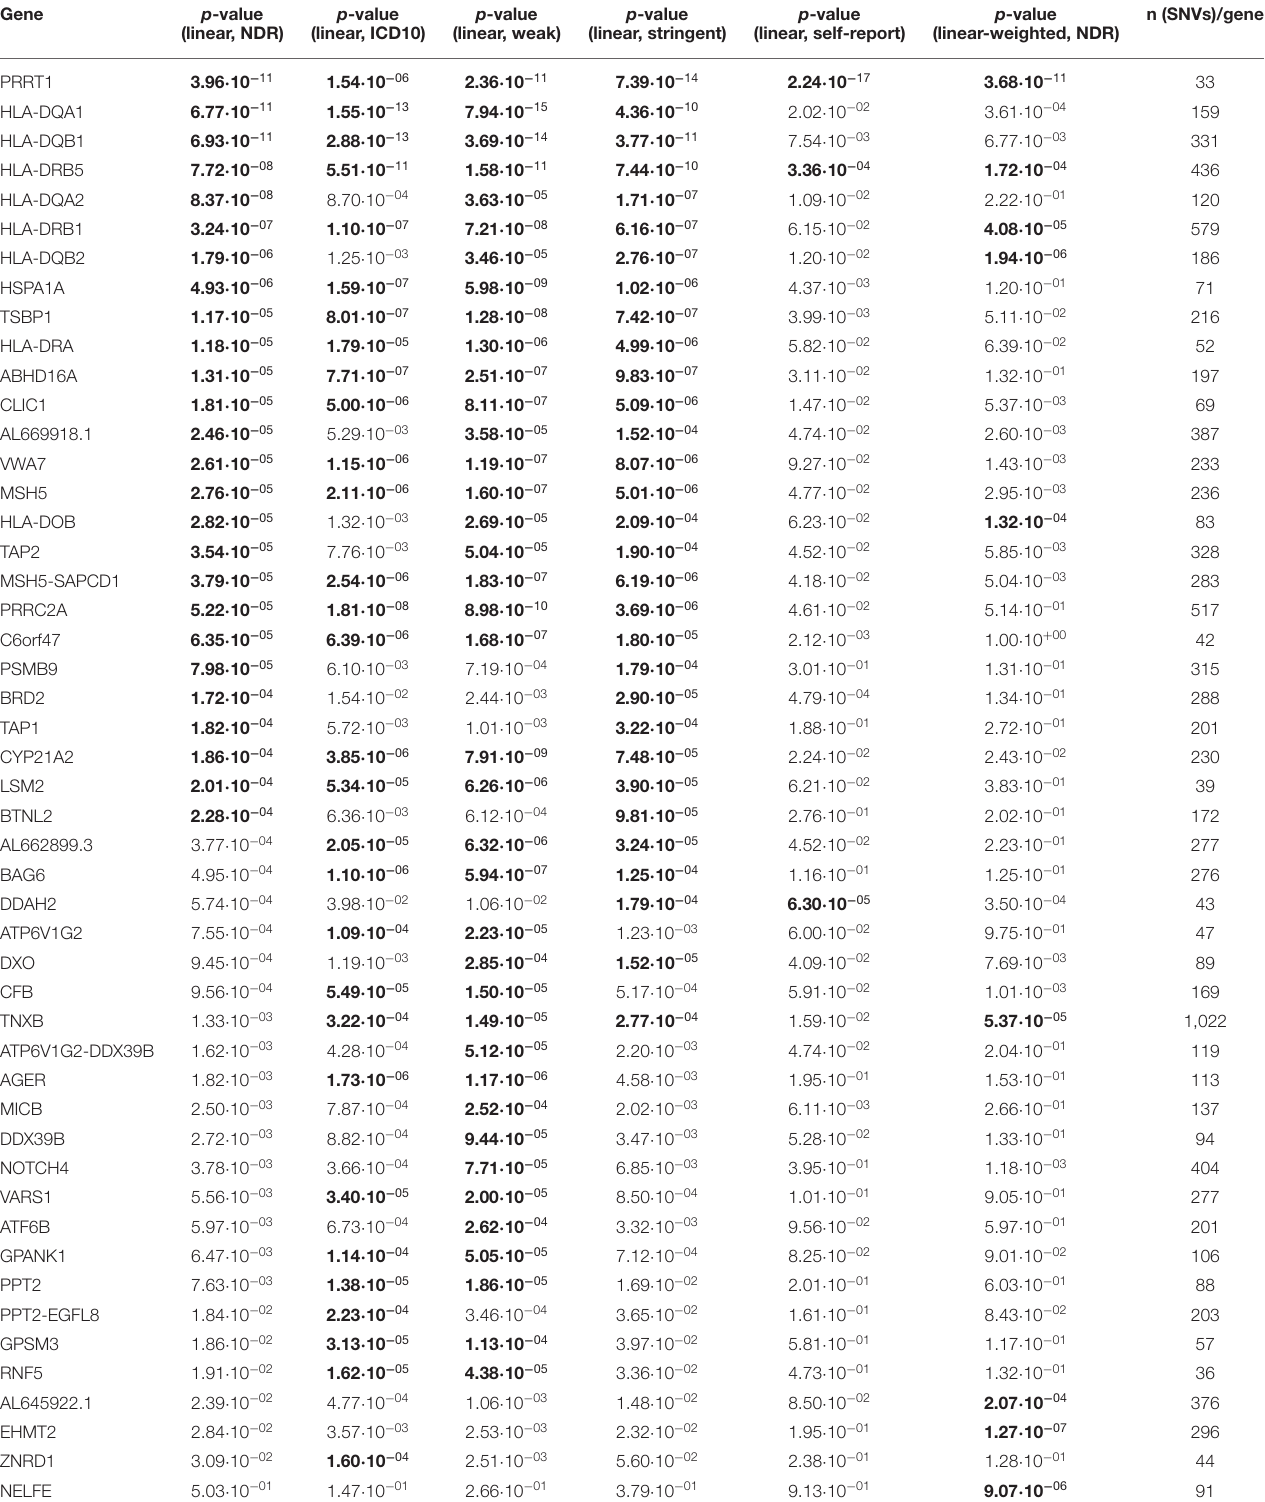
TABLE 1 | List of the 26 genes found to be associated with T1D, sorted by p -value of the association test using the NDR-defined T1D definition and the linear SKAT kernel after Bonferroni correction for 147 tests. Gene p -value p -value p -value p -value p -value p -value n (SNVs)/gene (linear, NDR) (linear, ICD10) (linear, weak) (linear, stringent) (linear, self-report) (linear-weighted, NDR)